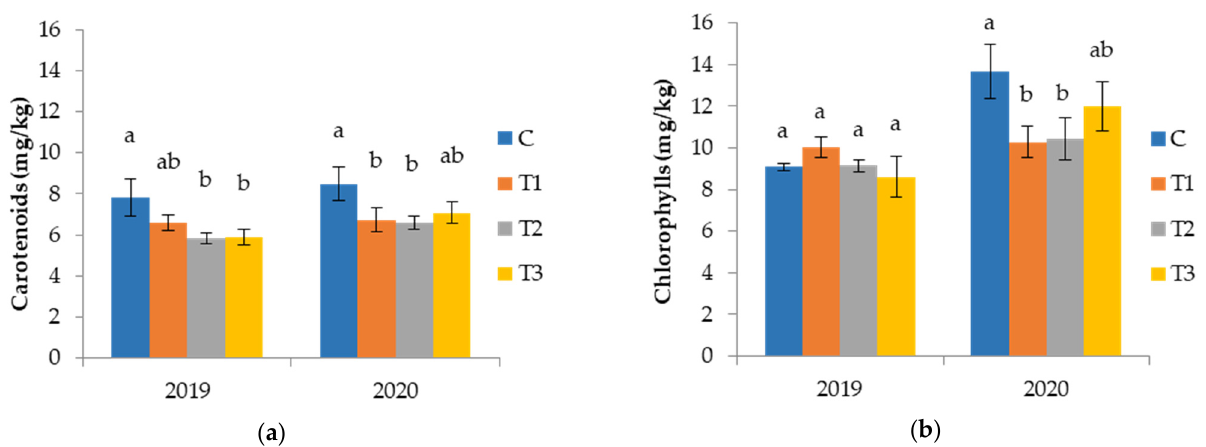
Figure 2. Pigment content: ( a ) carotenoids and ( b ) chlorophyll of virgin olive oils from Coratina cv. olive trees grown under different watering regimes during two crop seasons. Results are expressed as mean values ± standard deviation of three independent repetitions. Mean values labeled with different lowercase letter within the same harvesting year are statistically different (Tukey’s test, p < 0.05). Watering regimes: C—rainfed conditions; T 1 —deficit irrigation (the usual producer’s practice); T 2 —deficit irrigation acquired by SAN technology in respect to phenological stages; T 3 —irrigation with 100% of evapotranspiration (ETc) level.